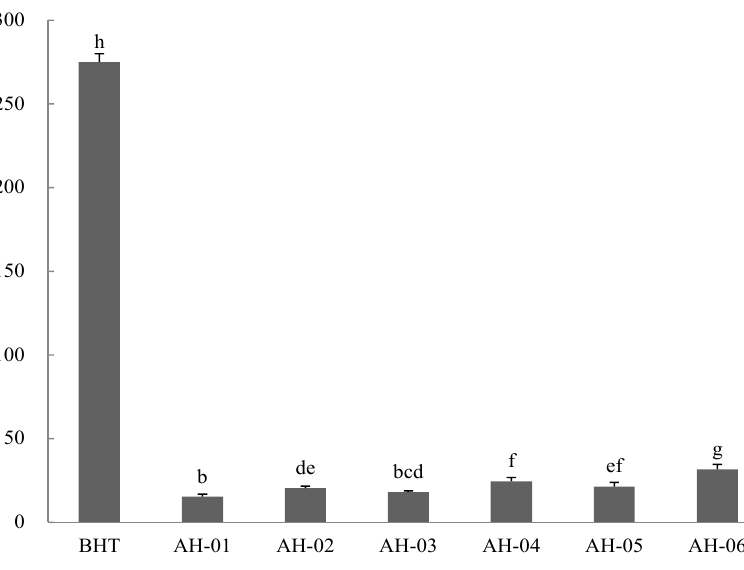
Figure 5. Ferric reducing capacity of AH samples. The values are expressed as μ mol Fe 2+ equivalents per gram of dried AH sample (mean ± SD). Values that share the same letter are not significantly different ( p <